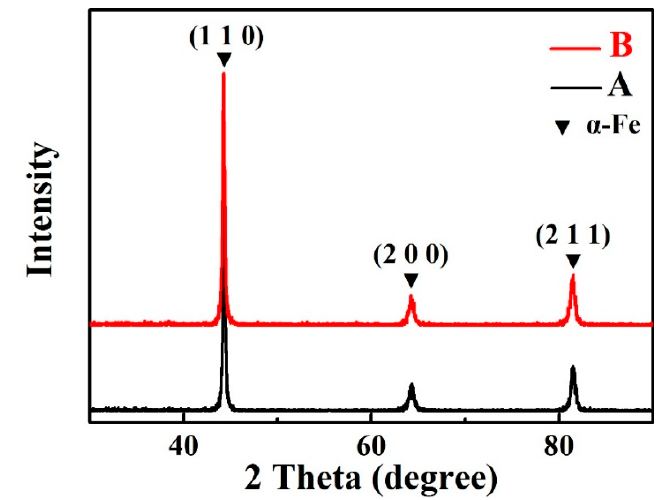
Figure 2. The XRD patterns of the as-HIPed alloys A and B.